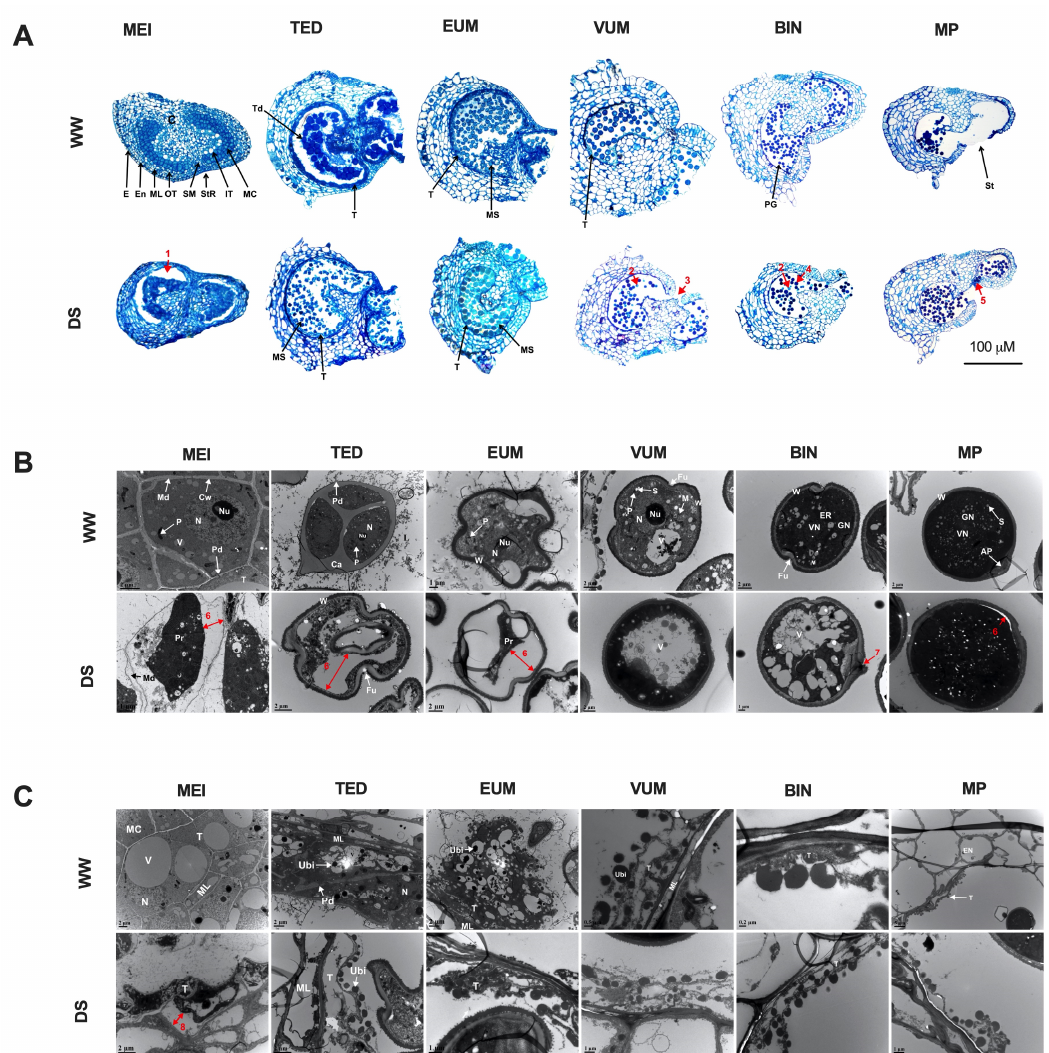
Figure 3. Drought stress affects anther, tapetum and pollen development. ( A ) Cross-sections of anthers at six different stages of development after 4 days under DS. WW, anthers from well-watered plants; DS, anthers from drought-stressed plants MEI, meiotic; TED, tetrad; EUM, early uninucleate microspore; VUM, vacuolated uninucleate microspore; BIN, binucleate; MP, mature pollen are different stages of pollen development; E, epidermis; En, endothecium; ML, middle layer; OT, outer tapetum; SM, septum; StR, stomium region; IT, inner tapetum; MC, meiotic cell; C, connective tissue; Td, tetrad; T, tapetum; MS, microspore; PG, pollen grain; St, stomium. ( B ) Transmission electron micrographs (TEMs) of developing pollen. Cw, cell wall; Nu, nucleolus; N, nucleus; Md, middle lamella; Ca, callose; W, pollen wall; V, vacuole: Fu, furrow; VN, vegetative nucleus; GN, generative nucleus; AP, aperture; S, starch granule. ( C ) TEMs of developing tapetum. ML, middle layer; Ubi, ubisch body; Pd, plasmodesma. Arrows: 1, gap between disengaged sporogenous and tapetum tissues; 2, aborted pollen; 3, precocious anther dehiscence; 4, abnormally enlarged pollen; 5, persistent stomium cells adhered to connective tissue; 6, gap between pollen wall and pollen protoplasm, 7, breakage in pollen wall and 8, gap between tapetum wall and shrank tapetum cell protoplasm due to